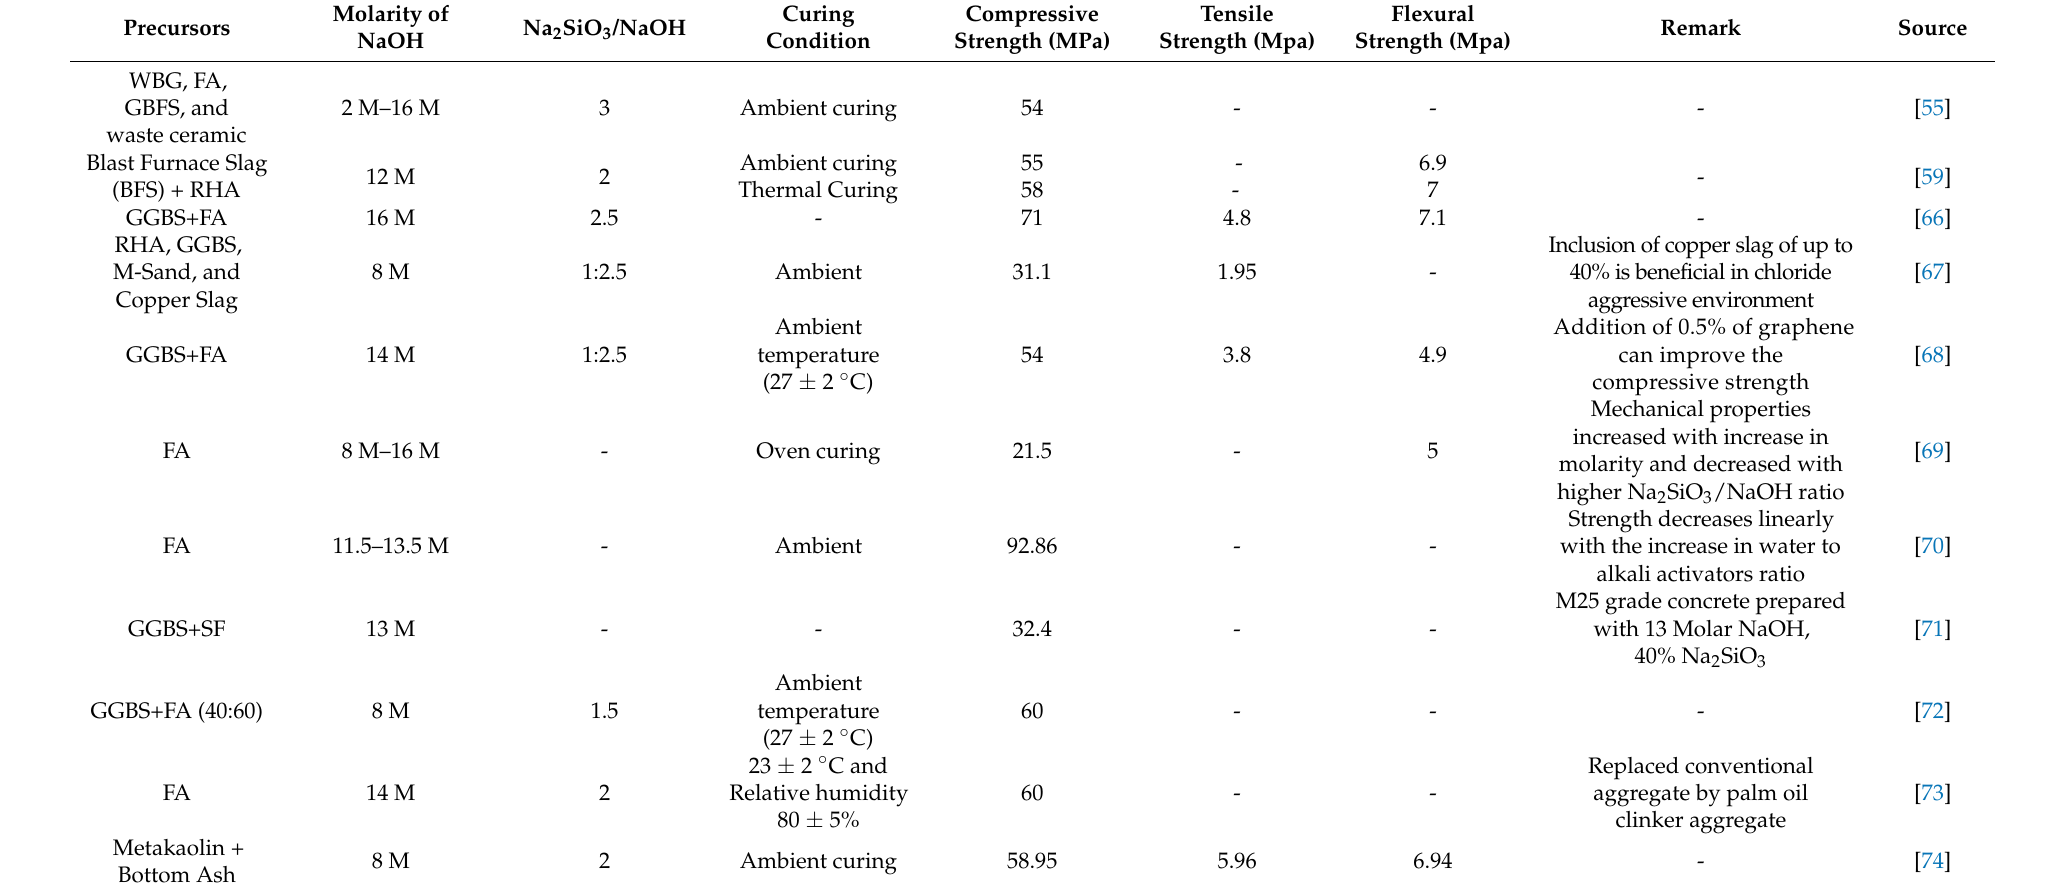
Table 3. Alkali-activated